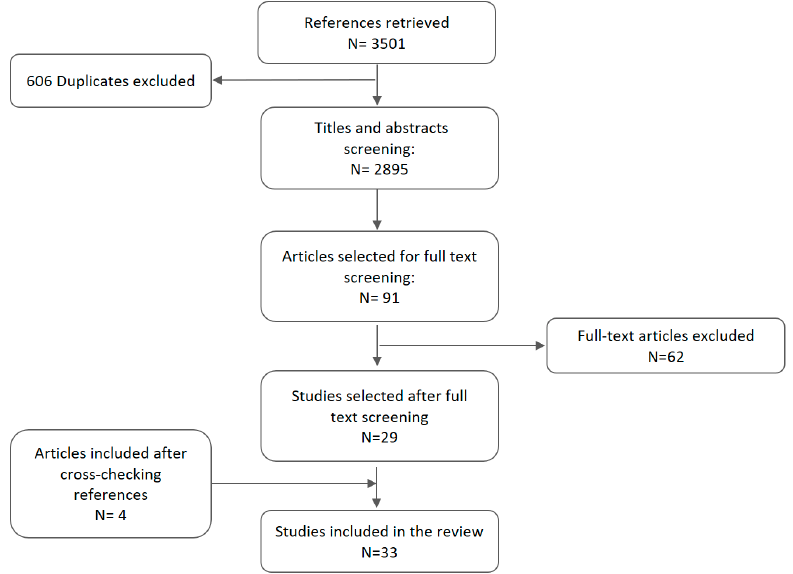
Figure 1. Flow chart of our study selection process.